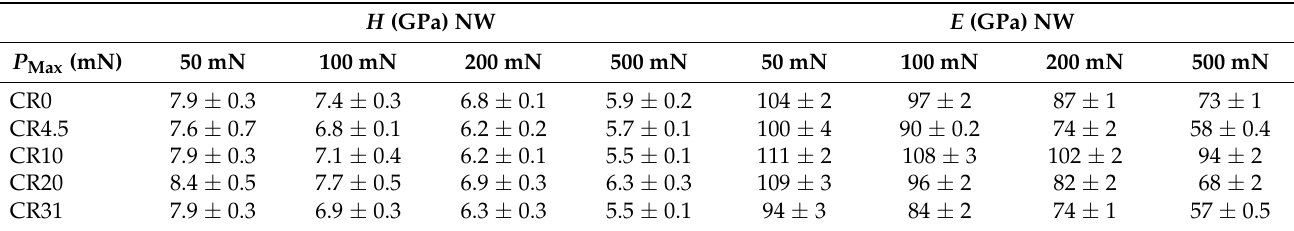
Table 3. H and E values of the NW plane in CR0, CR4.5, CR10, CR20, and CR31 at various P max values in between 50 and 500